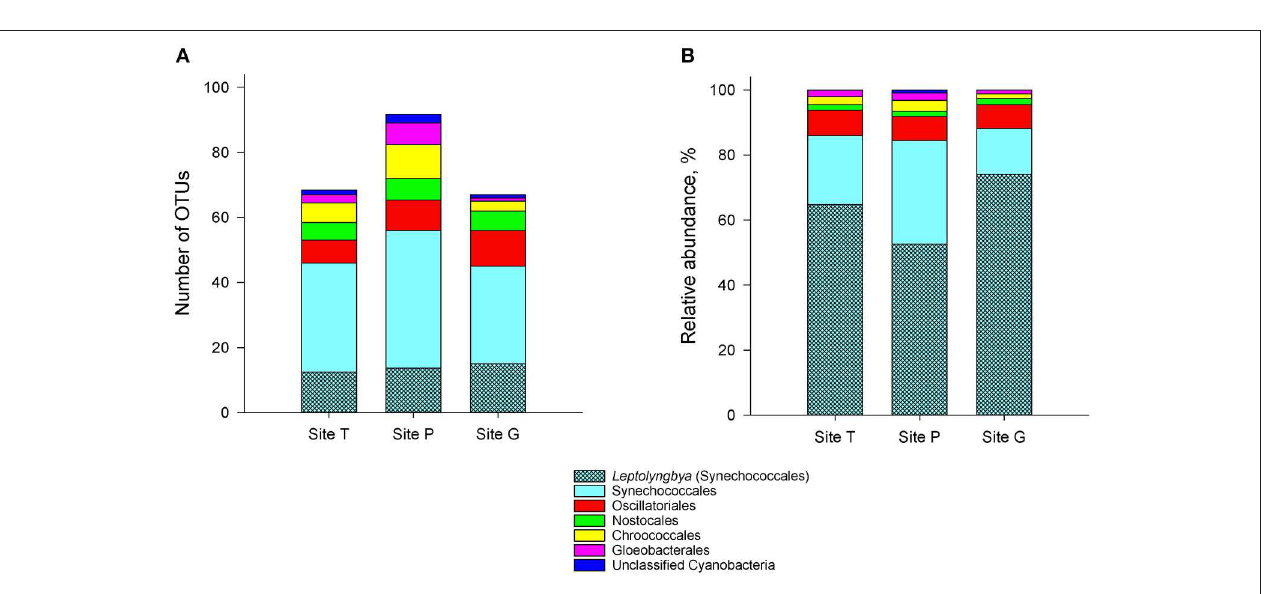
no yellow-green algae were isolated from Site P.